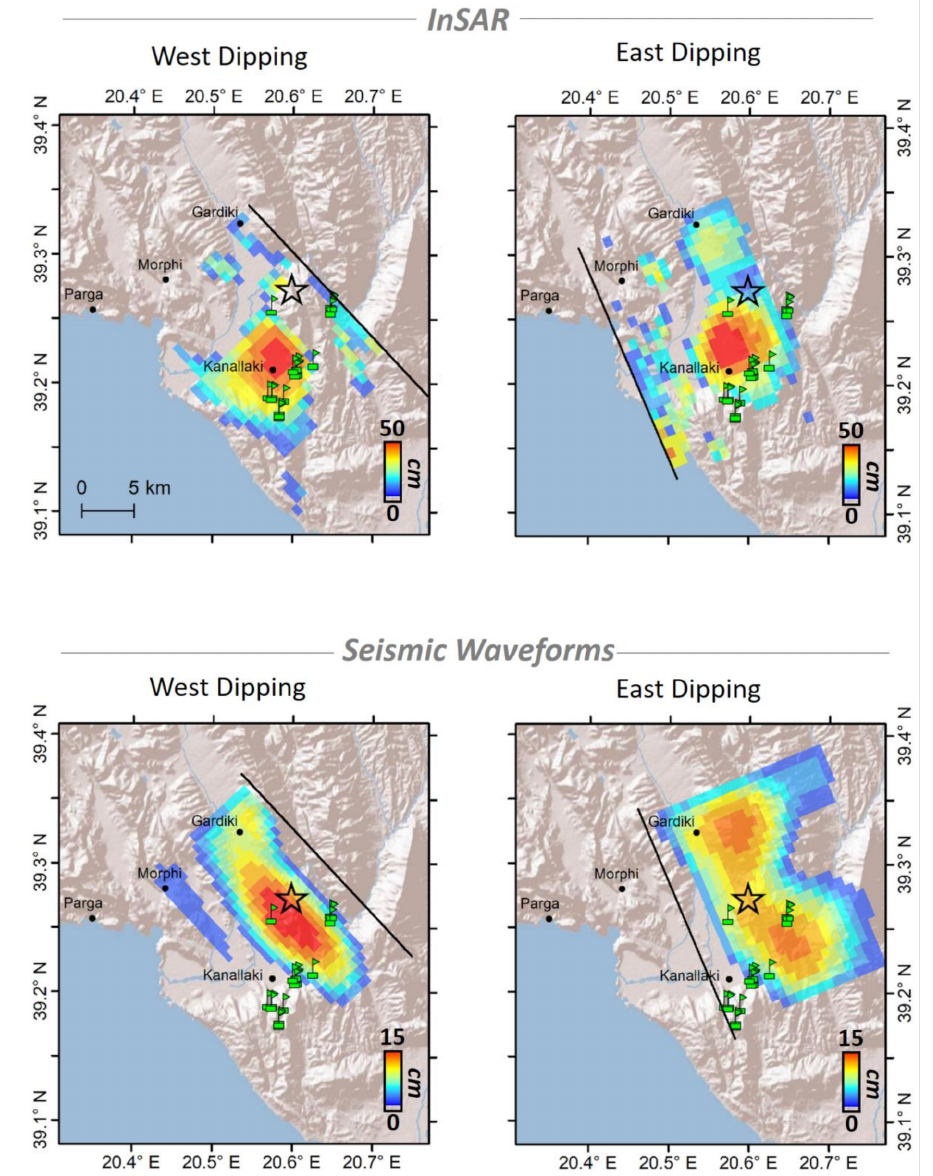
Figure 6. InSAR and seismic waveform slip distribution models. For both types of modelling, the west dipping geometry indicates one main slip patch, while the east dipping geometry indicates two main slip patches. The black line is the fault trace. The star denotes the mainshock. Light-green flag-marks are the locations of landslides (from [1]). The different scales of the models depend on the smoothing adopted in each